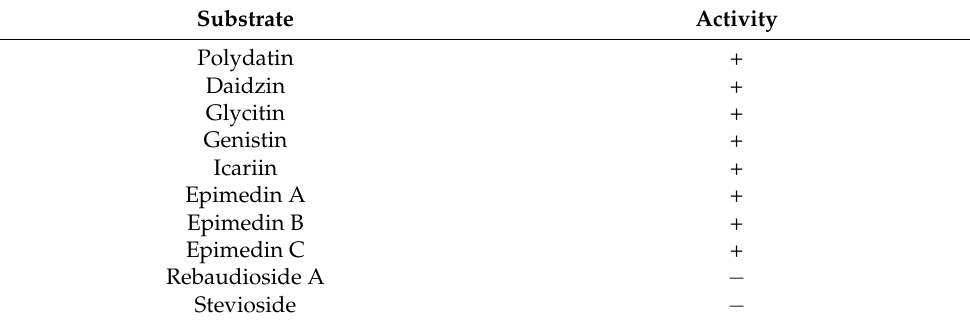
Table 1. Substrate profile of SpBGL1.